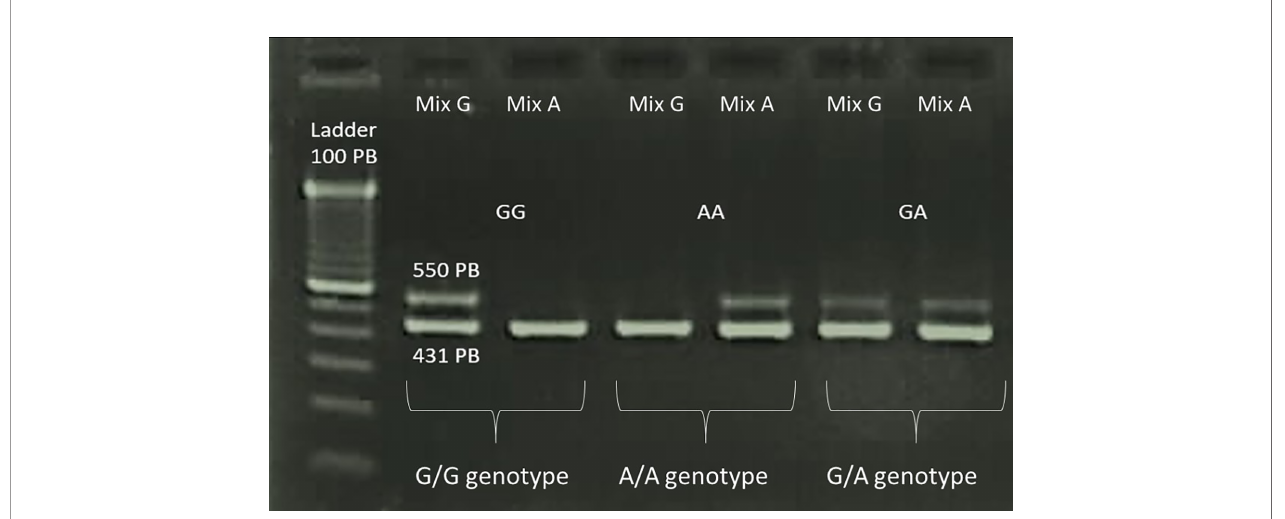
FIGURE 1 | Ampli fi ed products of the PCR-SSP assay for analysing the − 1082 A>G polymorphism of IL10 visualised in 2% agarose gel. Bands of 550 bp correspond to the IL10 fragment and bands of 431 bp correspond to the HGH fragment, which was used as an internal control for the reaction.